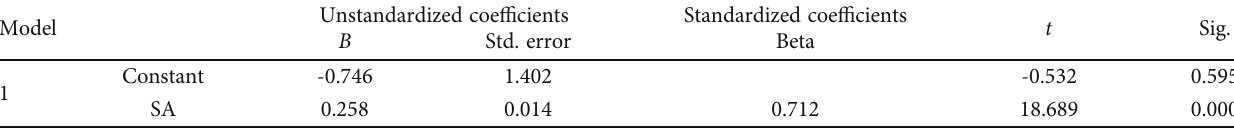
Table 8: Summary of coe ffi cients of assessment and professional